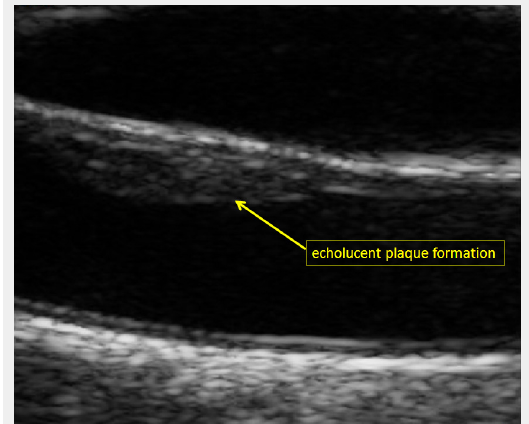
Echolucent carotid plaque formation at the near wall of the right common carotid artery (male study participant of the population- based Heinz Nixdorf Recall study)